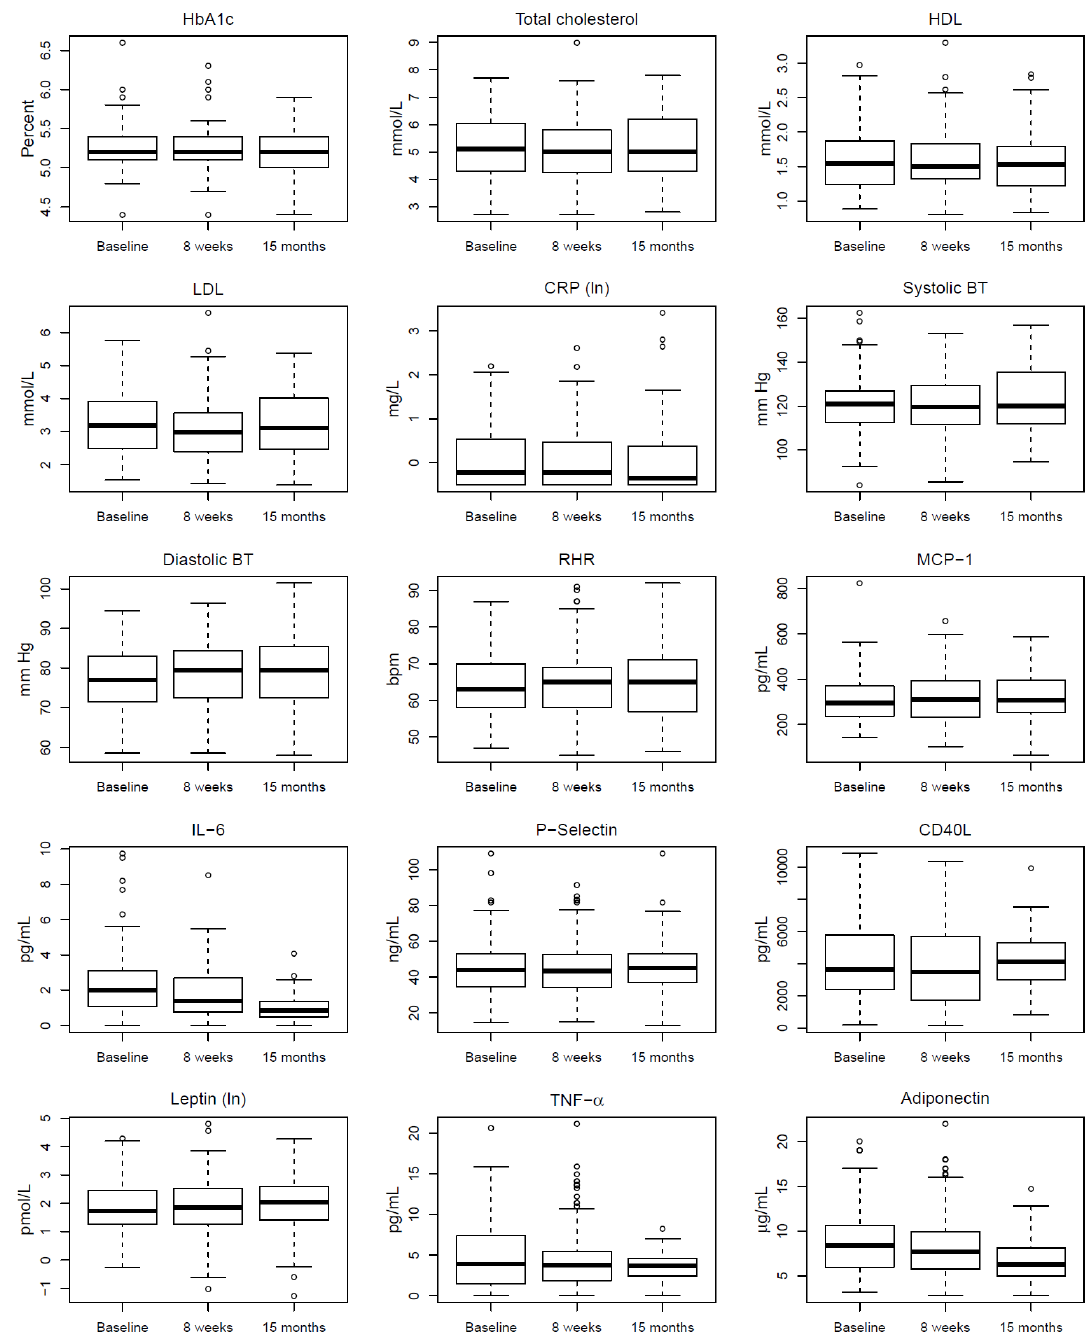
Figure 3. Changes in HbA1c, lipids, CRP, Blood pressure, RHR and selected biomarkers according to time; baseline, 8-week follow-up and 15-month follow-up. Plots are based on participants observed at all three time points.